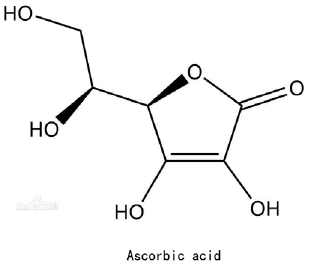
Figure 6. The chemical structure of ascorbic acid.